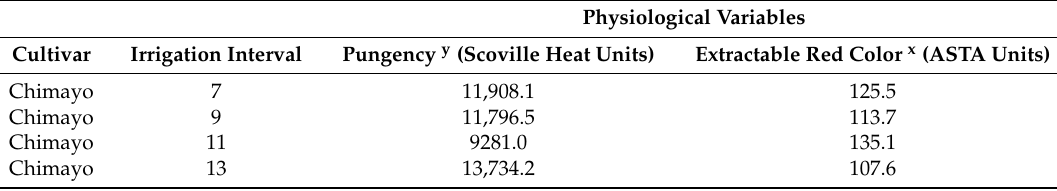
Table 6. Main effects and interactions of three cultivars and four irrigation intervals on physiological fruit characteristics,